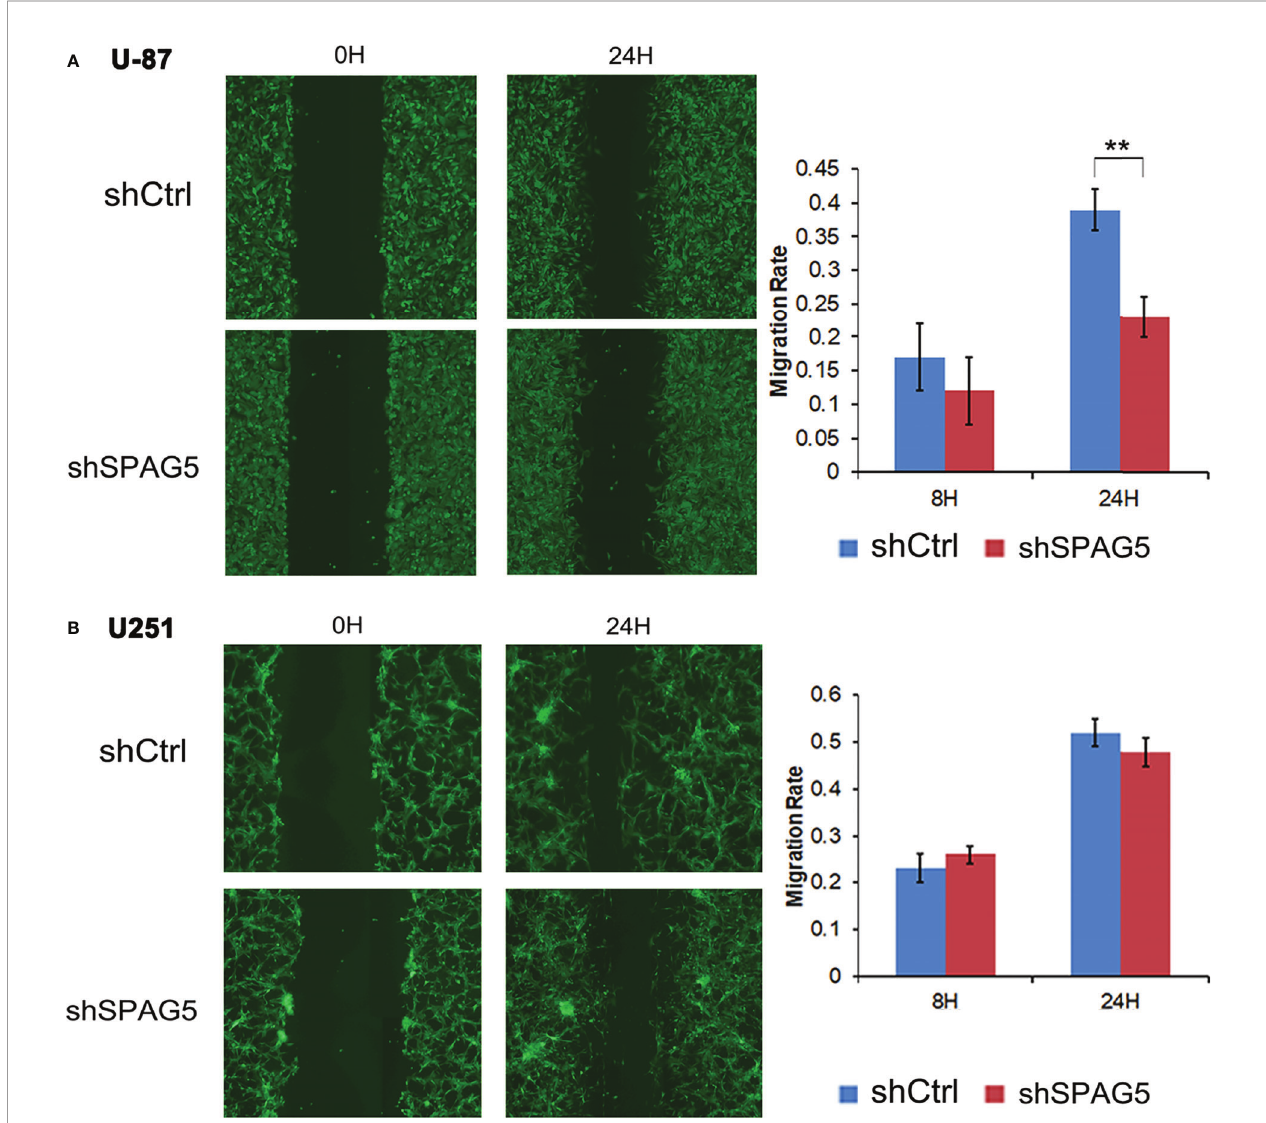
FIGURE 6 | Wound healing assay showed that shRNA-sperm-associated antigen 5 (SPAG5) transfection into (A) U-87 cells and (B) U251 cells for 24 h hampered cell migrating capacity compared with that of the negative control group. Bar chart showed the relative migration ability at 8 and 24 h Results were expressed as mean ± SD from three independent experiments. ** P <